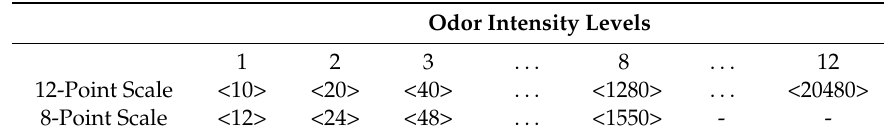
Table 2. Odor intensity referencing scales (OIRS).